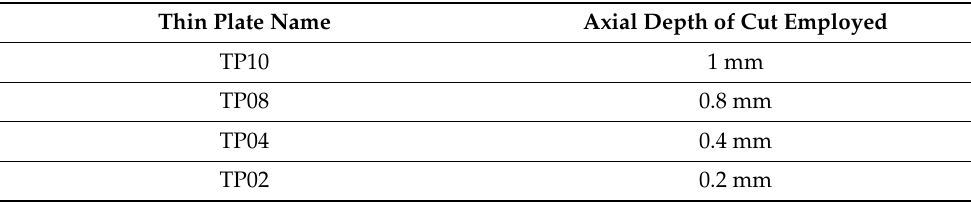
Table 2. Thin plates according to the depth of cut.